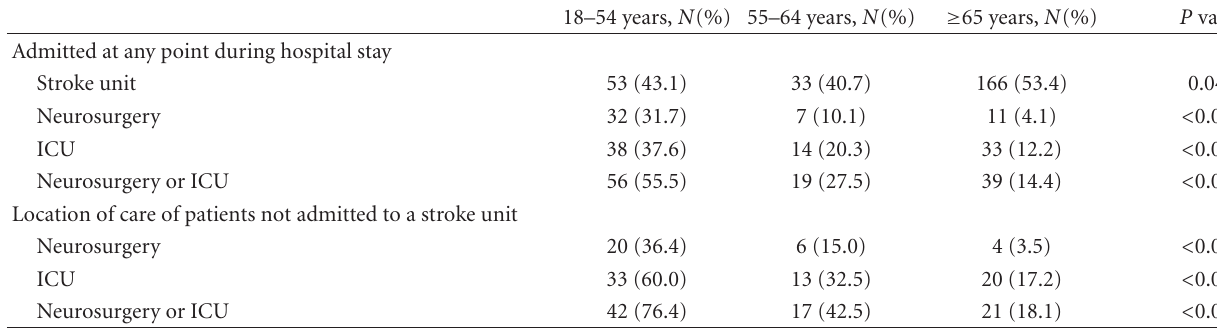
Table 3: Location of care of patients with PICH.